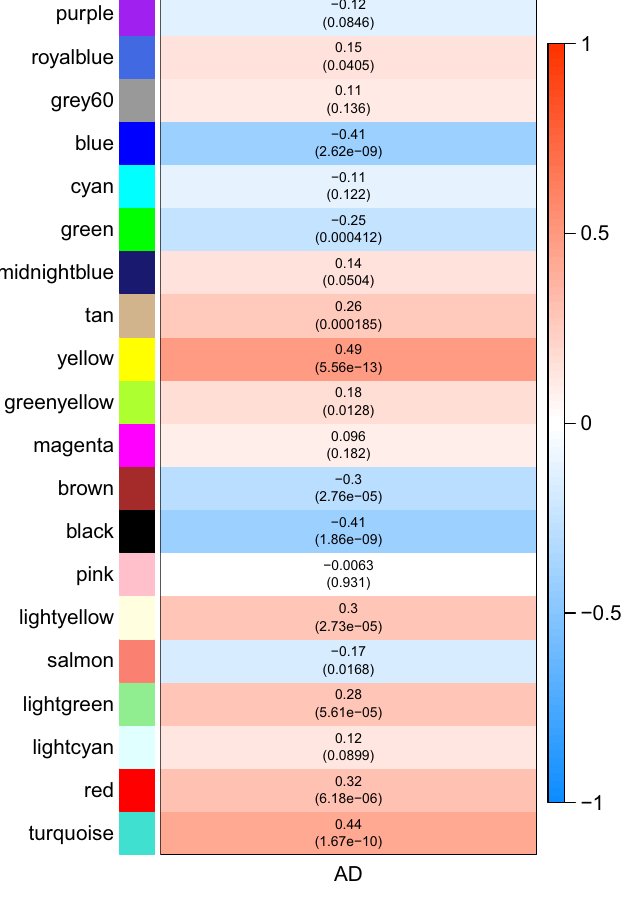
(Fig. 11a) and analyzed using Cytoscape, which yielded a sub-network with 11 candidates (MAPK3 (on chro- mosome 16), MAPK1 (on chromosome 22), SP1 (on chromosome 12), CASP3 (on chromosome 4), MAPT (on chromosome 17), BCL2 (on chromosome 18), APP (on chromosome 21), FOXO1 (on chromosome 13), ETS1 (on chromosome 11), MAPK9 (on chromosome 5), and EDN1 (on chromosome 6)) (Figs. 8b, 11b). We further